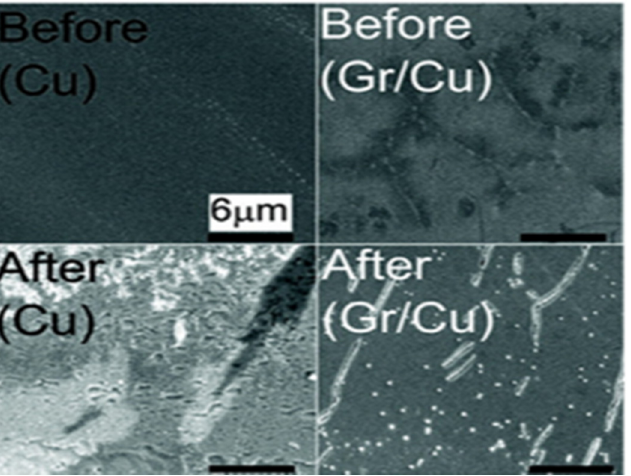
Figure 14. SEM images of pure Cu before and after corrosion, Cu+Gr before and after corrosion. “Reproduced with permission from [163], [Chemical Engineering Journal]; published by [Elsevier], 2019”.